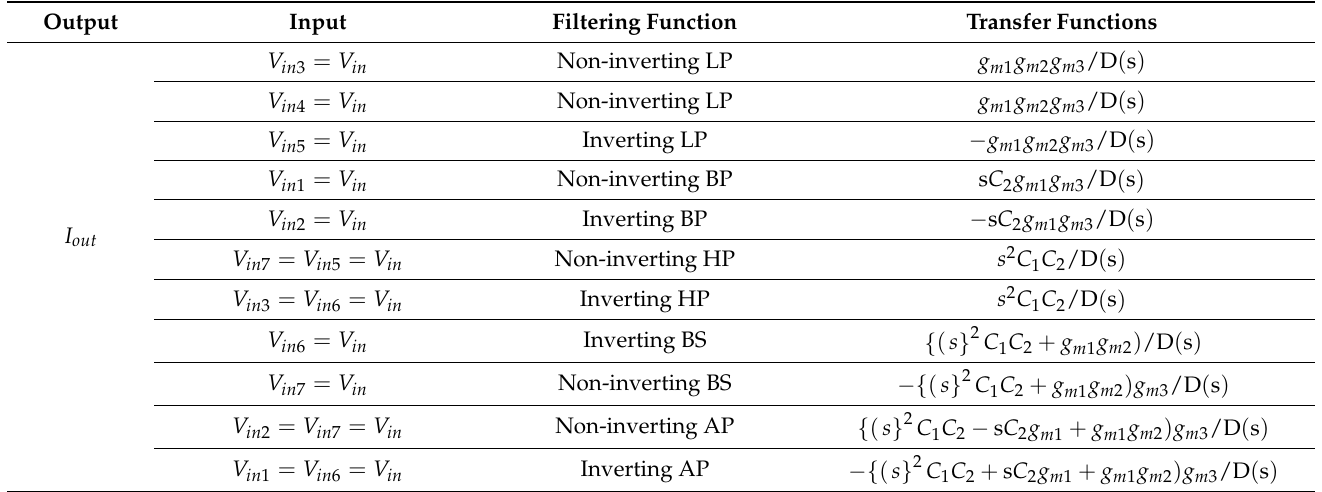
Table 2. Obtaining variant filtering function of transconductance-mode analog filter.